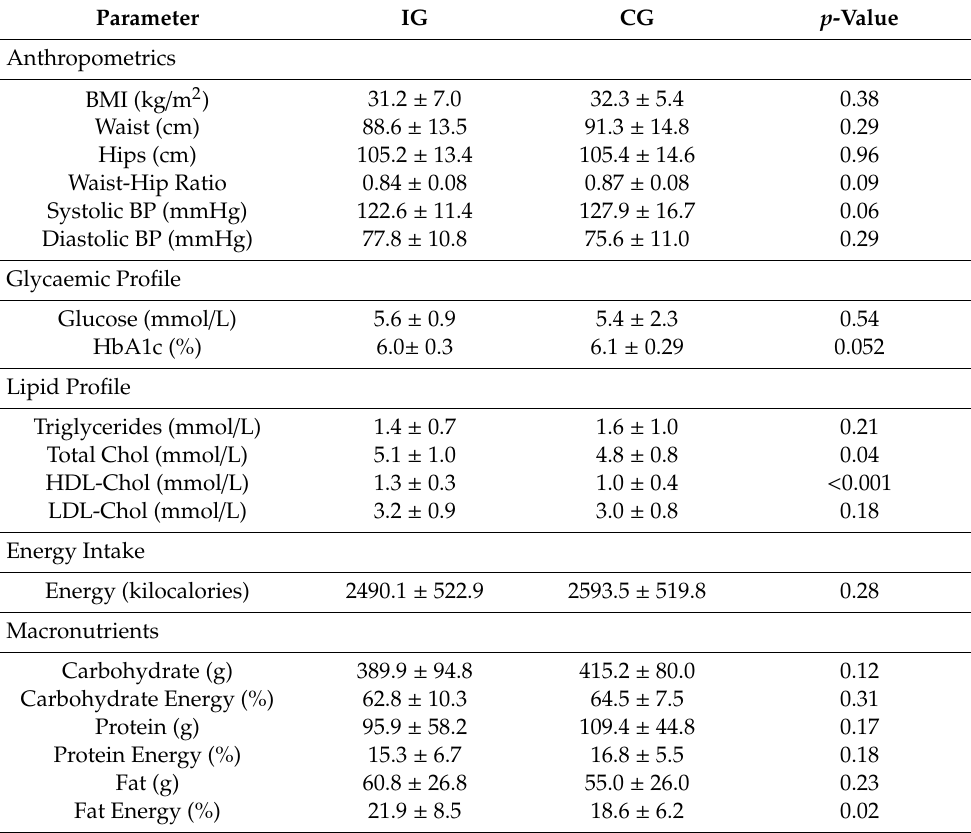
Table 2. Baseline anthropometric, clinical, and dietary intake comparison according to